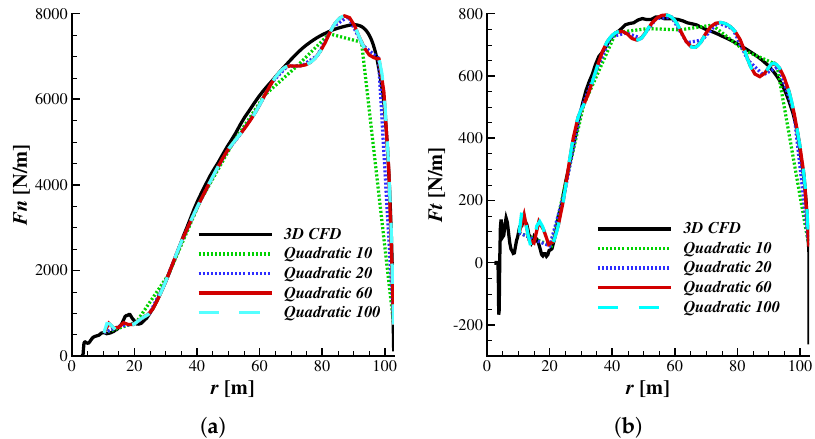
Figure 14. Effects of blade element discretization for radial-quadratic spline interpolation on the sectional force distributions along the blade radius; ( a ) normal force, ( b ) tangential